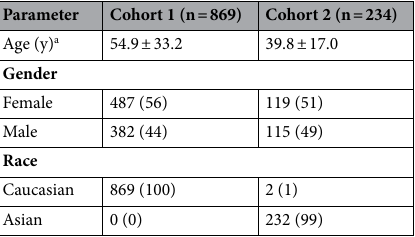
Table 1. Characteristics of the study sample with percentages in parentheses. Cohort 1 from University Hospital of Tampere (TAUH) and Cohort 2 from Chiang Mai University (CMU). a Mean and standard